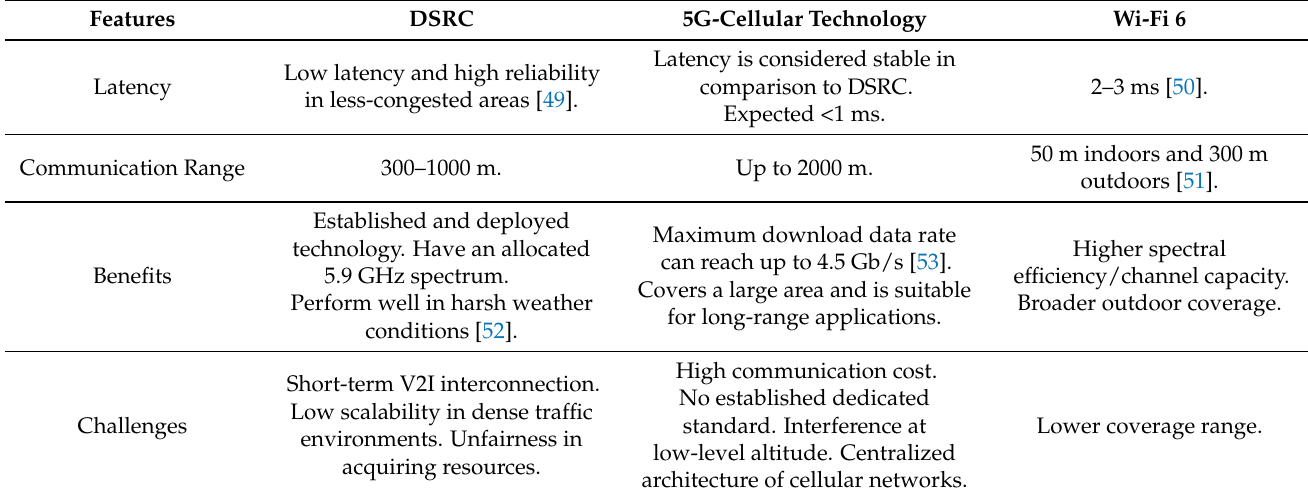
Table 1. Comparison between DSRC, 5G-cellular, and Wi-Fi 6